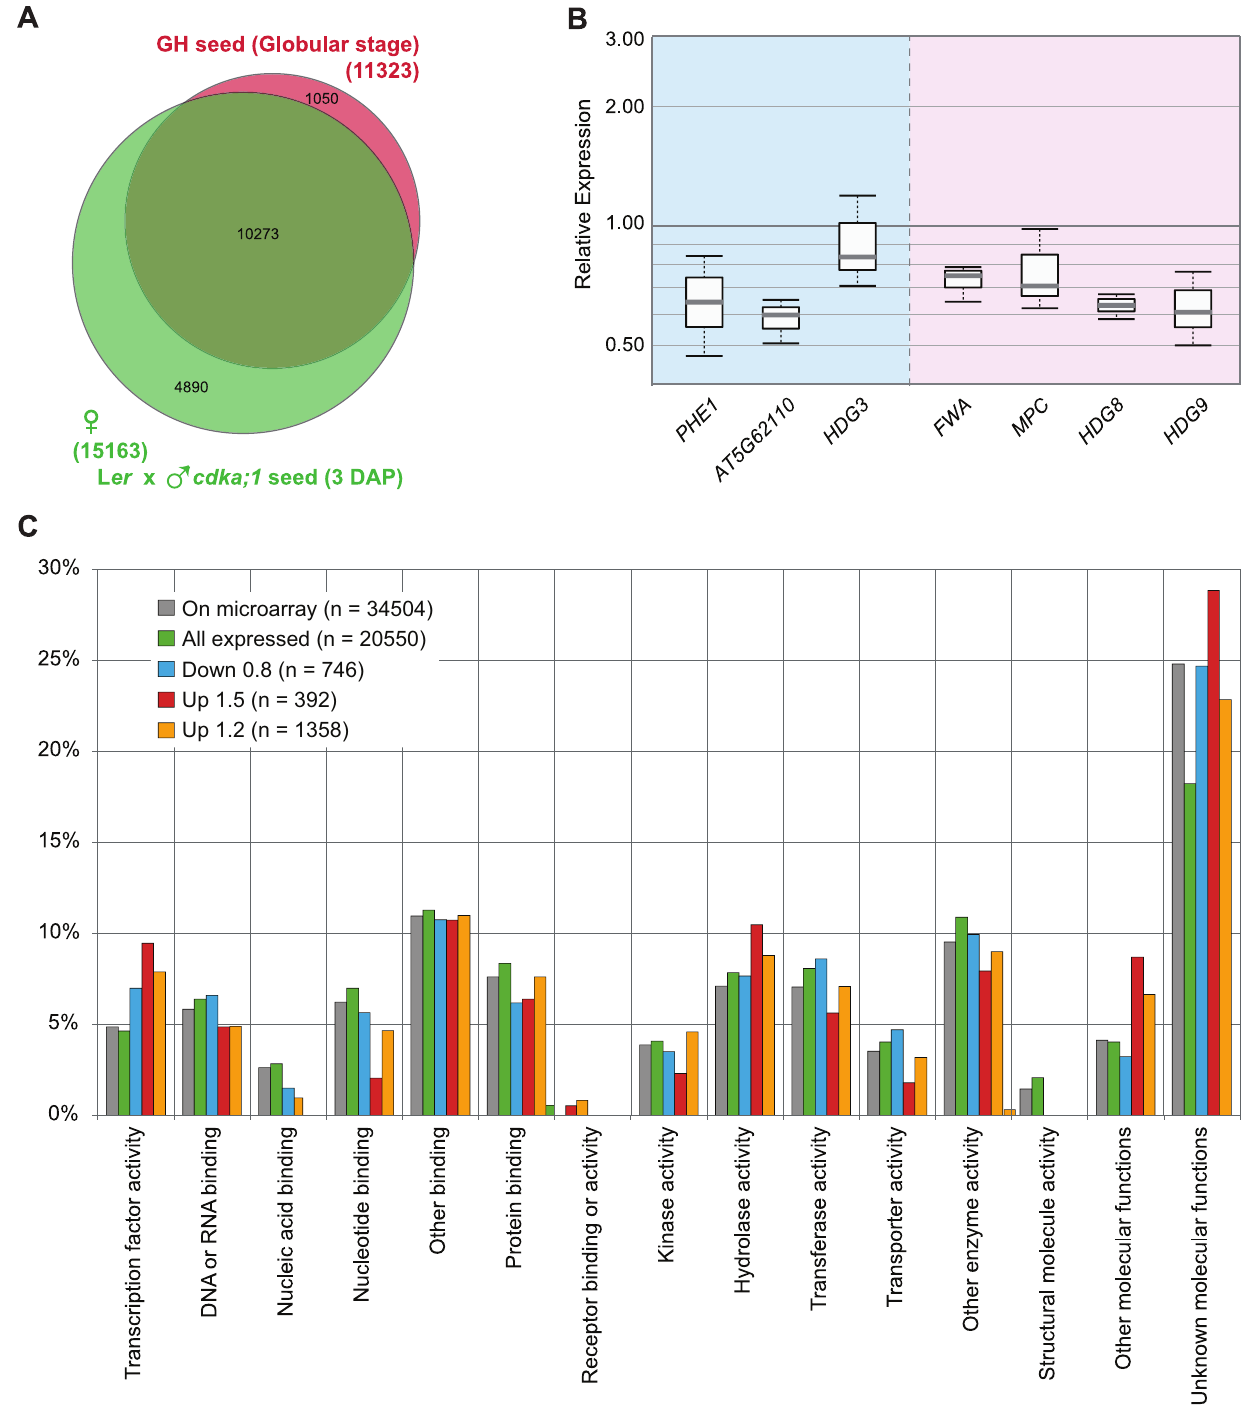
Figure 1. Analysis of cdka;1 microarray profiles. (A) Venn diagram representing overlap of genes expressed in globular stage seeds of Arabidopsis Ws-0 plants (red) and genes expressed in 3 DAP seeds from L er plants pollinated with Col cdka;1 pollen (green). As high as 67.8% of the cdka;1 set and 90,7% of the GH set genes were found in the overlap. Gene numbers refer to the reference set of genes (see material and methods). GH: Goldberg & Harada laboratories (http://www.seedgenenetwork.net). (B) Boxplot showing the reduced relative expression of known maternally imprinted (blue background) and paternally imprinted (pink background) genes in the L er x cdka;1 versus L er x Col seeds. Calculations are based on values taken from three independent biological replicas. (C) GO functional classification of microarray expression data. Deregulated genes identified in the microarray experiment were functionally classified regarding their molecular function using the GO Slim classification system (http://www. arabidopsis.org/tools/bulk/go/). The total number of unique GO-term:locus assignments for each group is indicated (n). The functional classifications of all genes present on the microarray (On microarray) and all genes having a present call (All expressed) have been included for comparison. The cut- off for deregulation is # 0.8 for the downregulated group, and $ 1.5 and $ 1.2 for the upregulated groups.